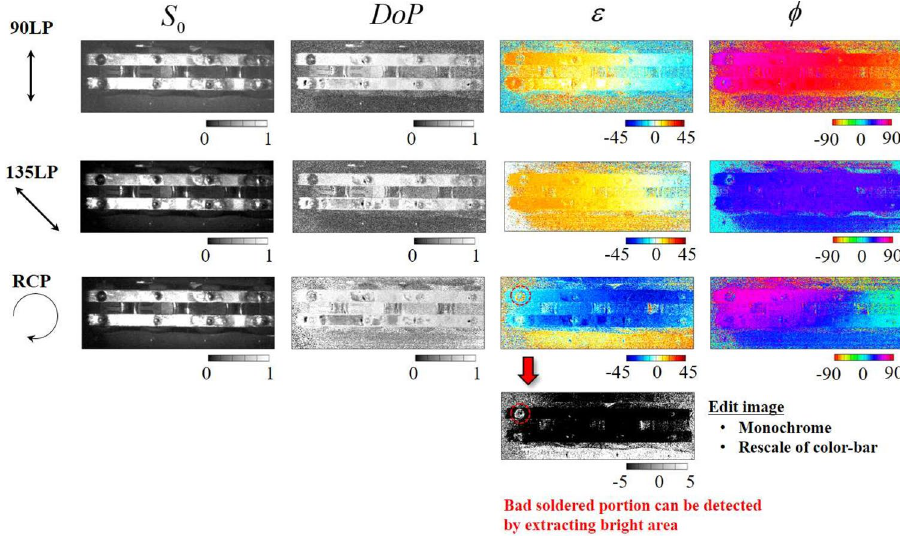
Figure 9. Intensity, degree of polarization, ellipticity angle, and azimuth angle calculated from the Stokes parameters of the soldered condenser that were acquired using the PPPI